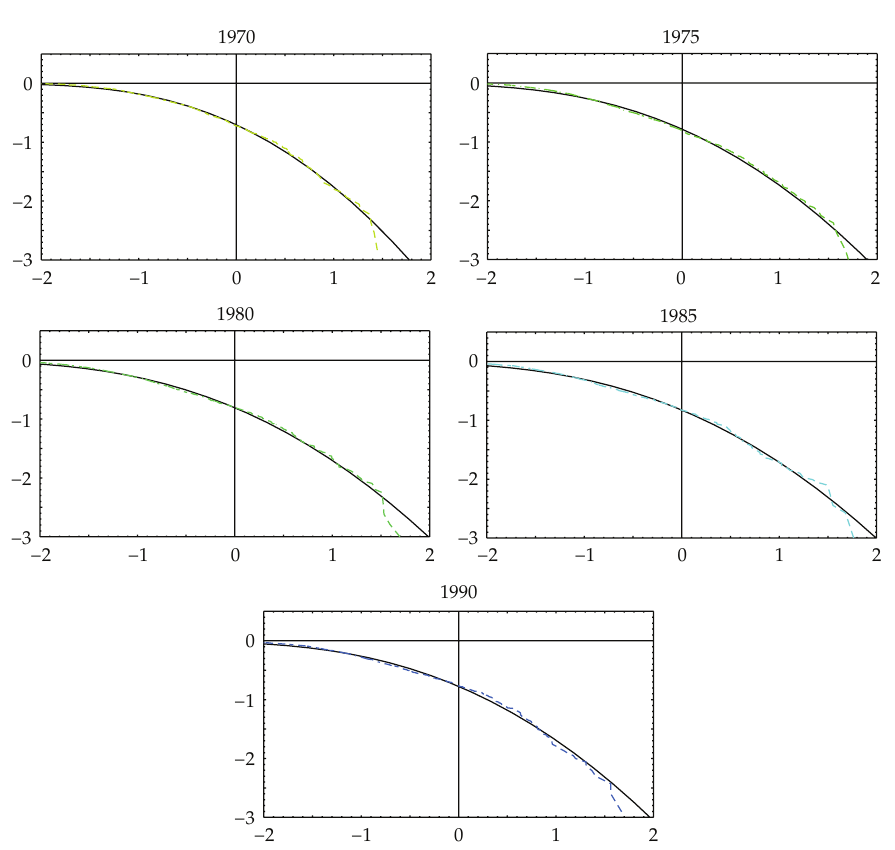
Figure 6: Rank-size plots with the log-normal fits for the years 1970, 1975, 1980, 1985, and 1990 in log-log scale. In all the cases the over-all fit is good, except for the small systematic di ff erences, which is a sign of the thinning